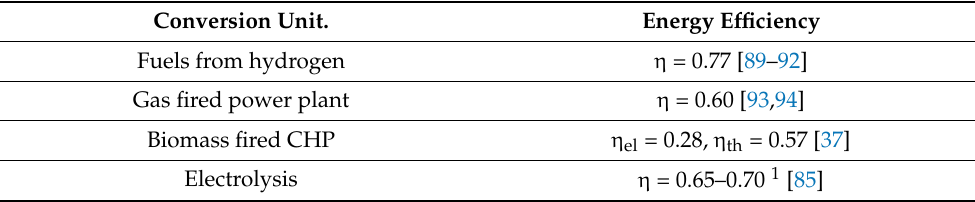
Table A13. Conversion efficiencies of the scenario Sufficiency.